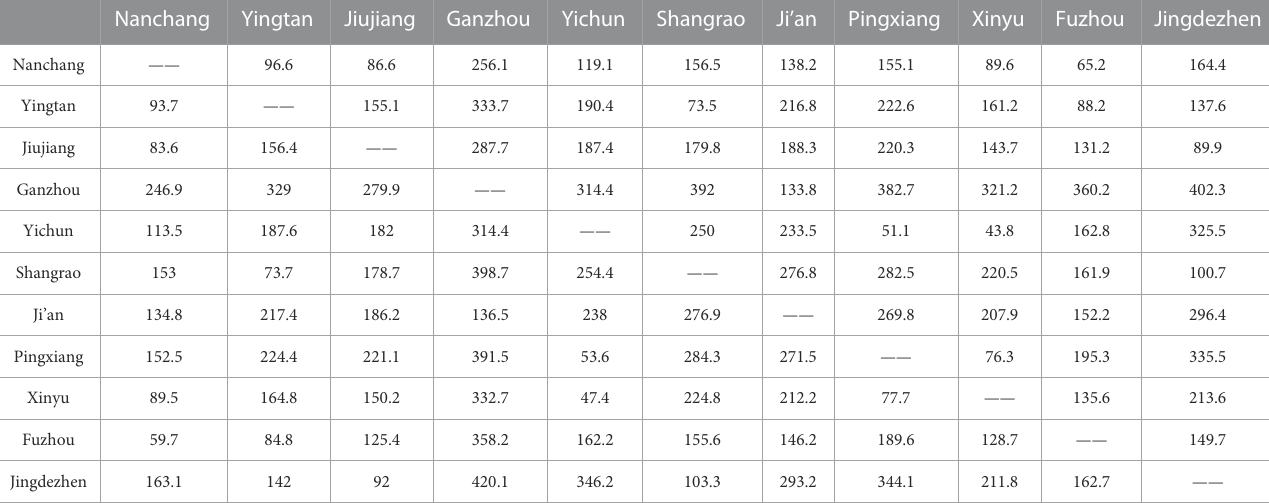
TABLE 7 Economic distance between cities after the opening of high-speed